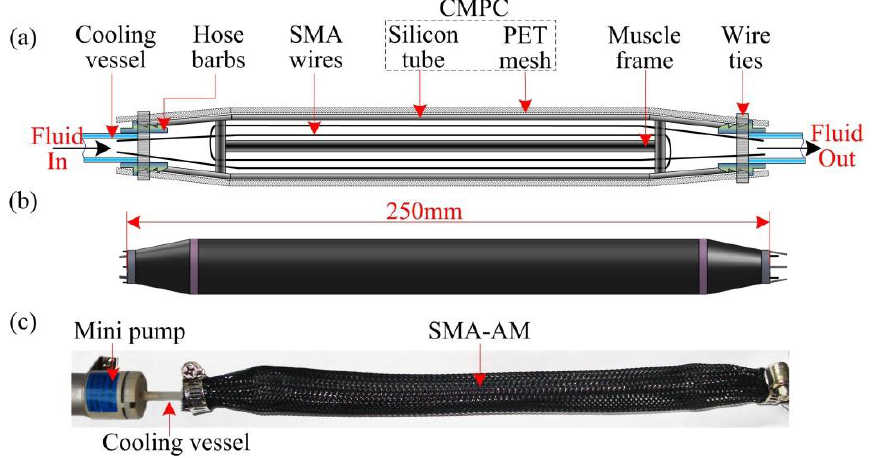
Figure 1. Schematic ( a ), CAD model ( b ) and picture ( c ) of the SMA-AM structure.